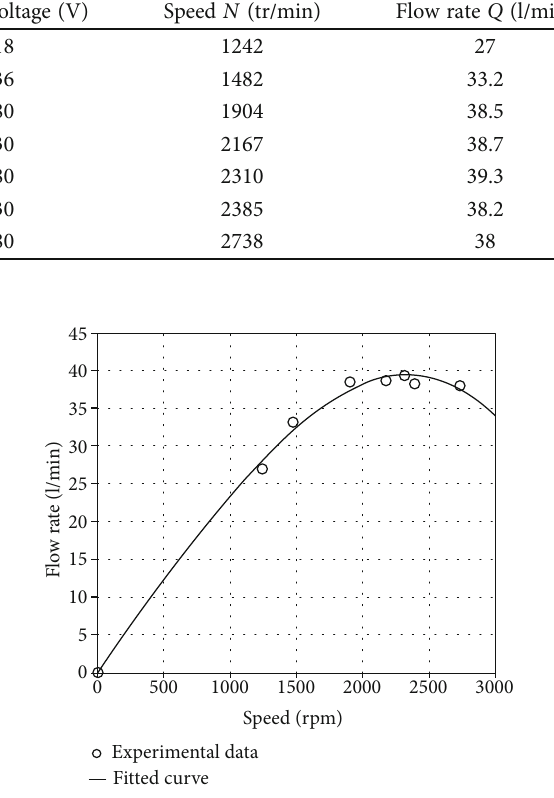
Figure 7: Identi fi cation of the fl ow-speed